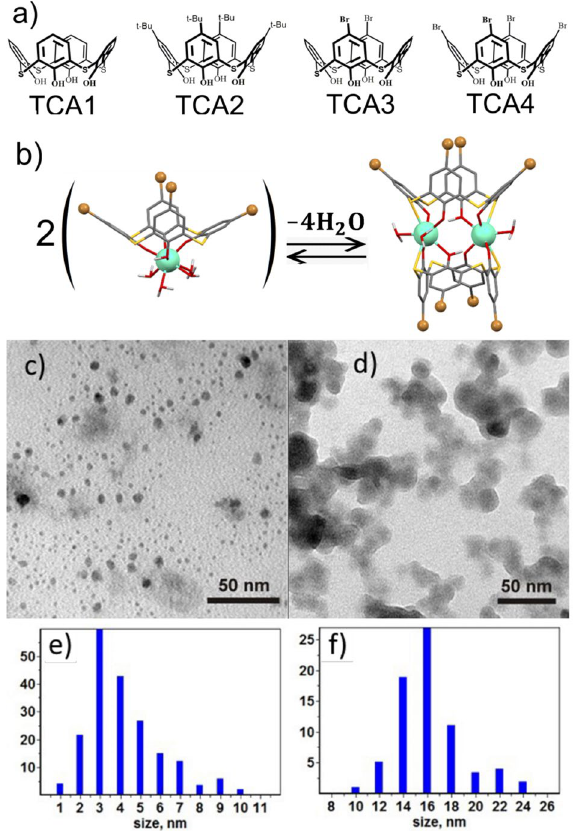
Figure 1. ( a ) Structures of thiacalix[4]arene ligands TCAn (n = 1–4). ( b ) Schematic illustration of equilibrium between 2:2 and 1:1 exemplified for Tb 3+ complex with the TCA4. TEM images of dried ( c ) PSS-[Tb 2 (TCA3) 2 ] and ( d ) PSS-[Tb 2 (TCA4) 2 ]. ( e , f ) Corresponding size distribution